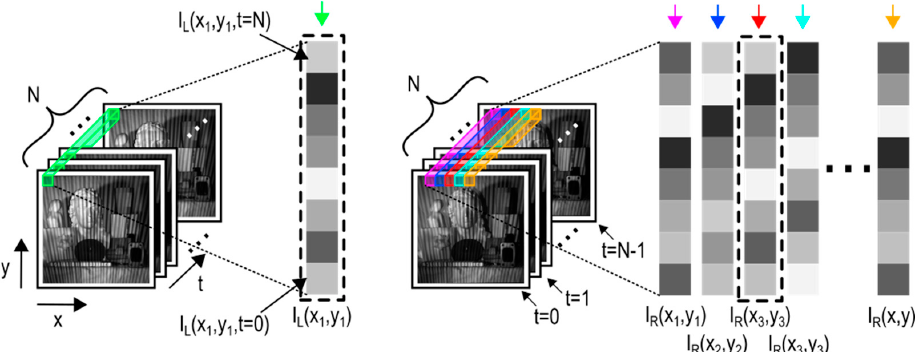
Figure 1. Correspondence search between individual “temporal pixels” from left (image stack I L ) and right (image stack I R ) view. The closest match to temporal pixel I L (x 1 , y 1 ) (green arrow) is the temporal pixel I R (x 3 , y 3 ) (red arrow).